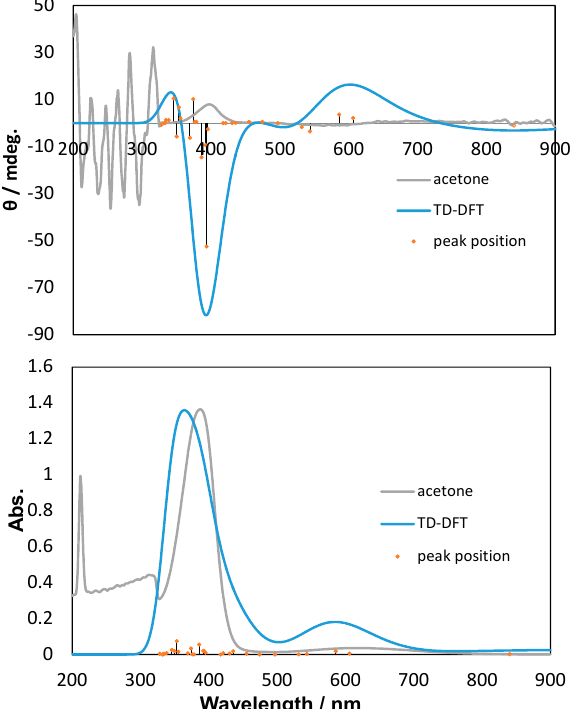
Figure 4. Experimental (in acetone solution) and simulated (UB3LYP/6-31G(d)) UV-Vis and CD spectra of Cu .